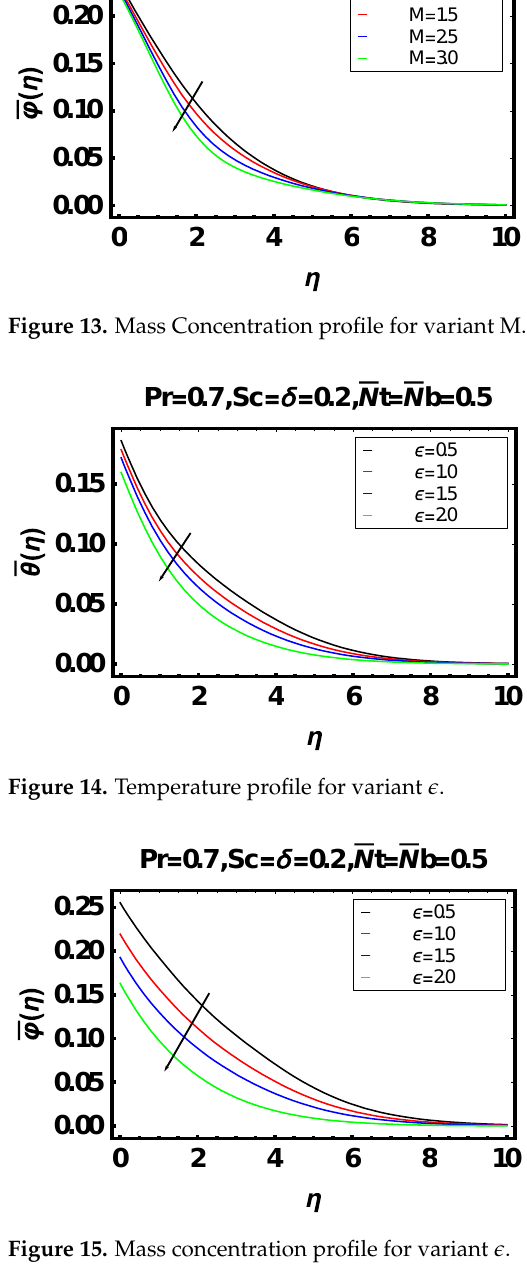
Figure 15. Mass concentration profile for variant ϵ .